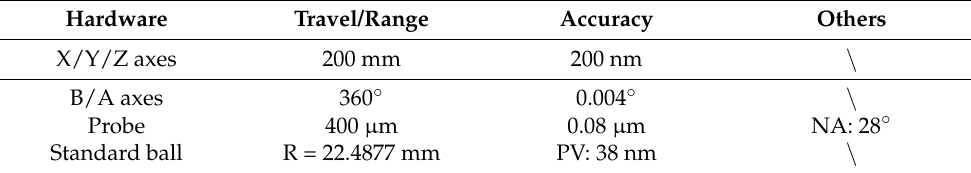
Figure 8. A photograph of the measurement system. Table 3. The hardware parameters of the measurement